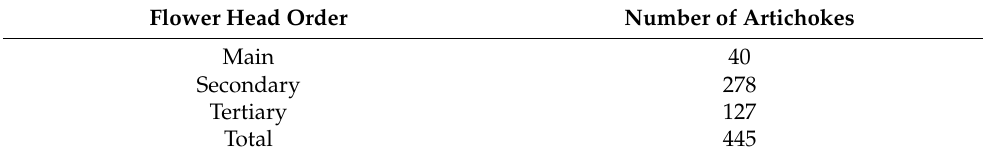
Table 1. Number of artichokes produced in each type of flower head order for ‘Lorca’ cultivar. Flower Head Order